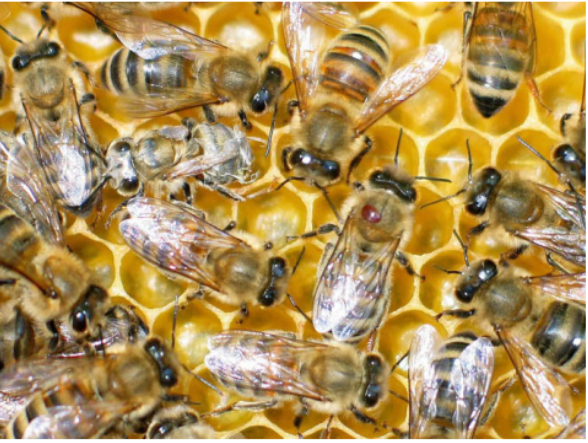
Figure 1. V.-mite on an adult bee worker (in the centre) [1] Reprinted from Publication Journal of Invertebrate Pathology, 103, P. Rosenkranz; P. Aumeier; B. Ziegelmann, Biology and control of Varroa destructor, 96–101, Copyright (2010), with permission from